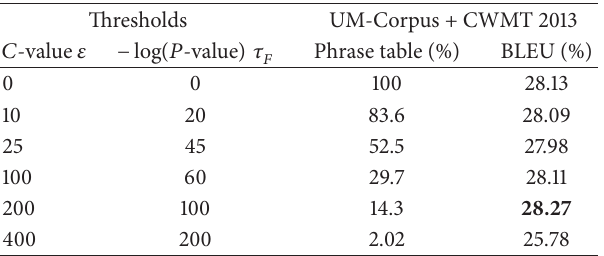
Table 11: 𝐶 -value and 𝑃 -value threshold effect on the phrase table size and BLEU scores.